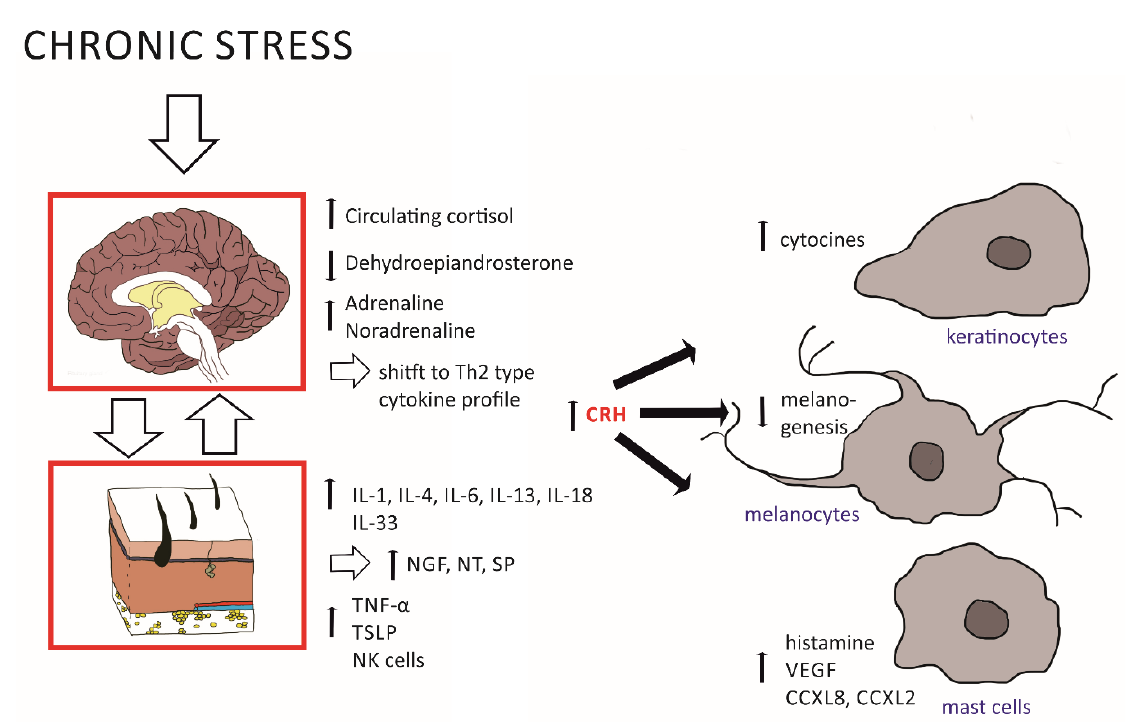
Figure 2. Chronic stress acts on the central as well as peripheral systems to induce adequate immune responses. An increase in circulating cortisol and levels of adrenaline and noradrenaline together with a decrease in dehydroepiandrosterone leads to a Th2-type shifted cytokine profile. In both the central and peripheral HPA axes, CRH and its downstream cascade are elevated. This leads to a release of TNF- α , TSLP, and of pro-inflammatory cytokines, such as IL-1, IL-4, IL-6, IL-13, IL-18, and IL-33. Especially, IL-33 is of major impact as it triggers an increase in NGF, NT, and SP levels. NT, in turn, acts on mast cells to induce the release of histamine, while SP activates both keratinocytes and mast cells and causes the release of VEGF from the latter. The activation of the respective cells of the skin leads to the release of even more CRH, which exacerbates inflammatory processes by causing malfunctions of the skin barrier, decreasing melanogenesis, and thus increasing permeability.